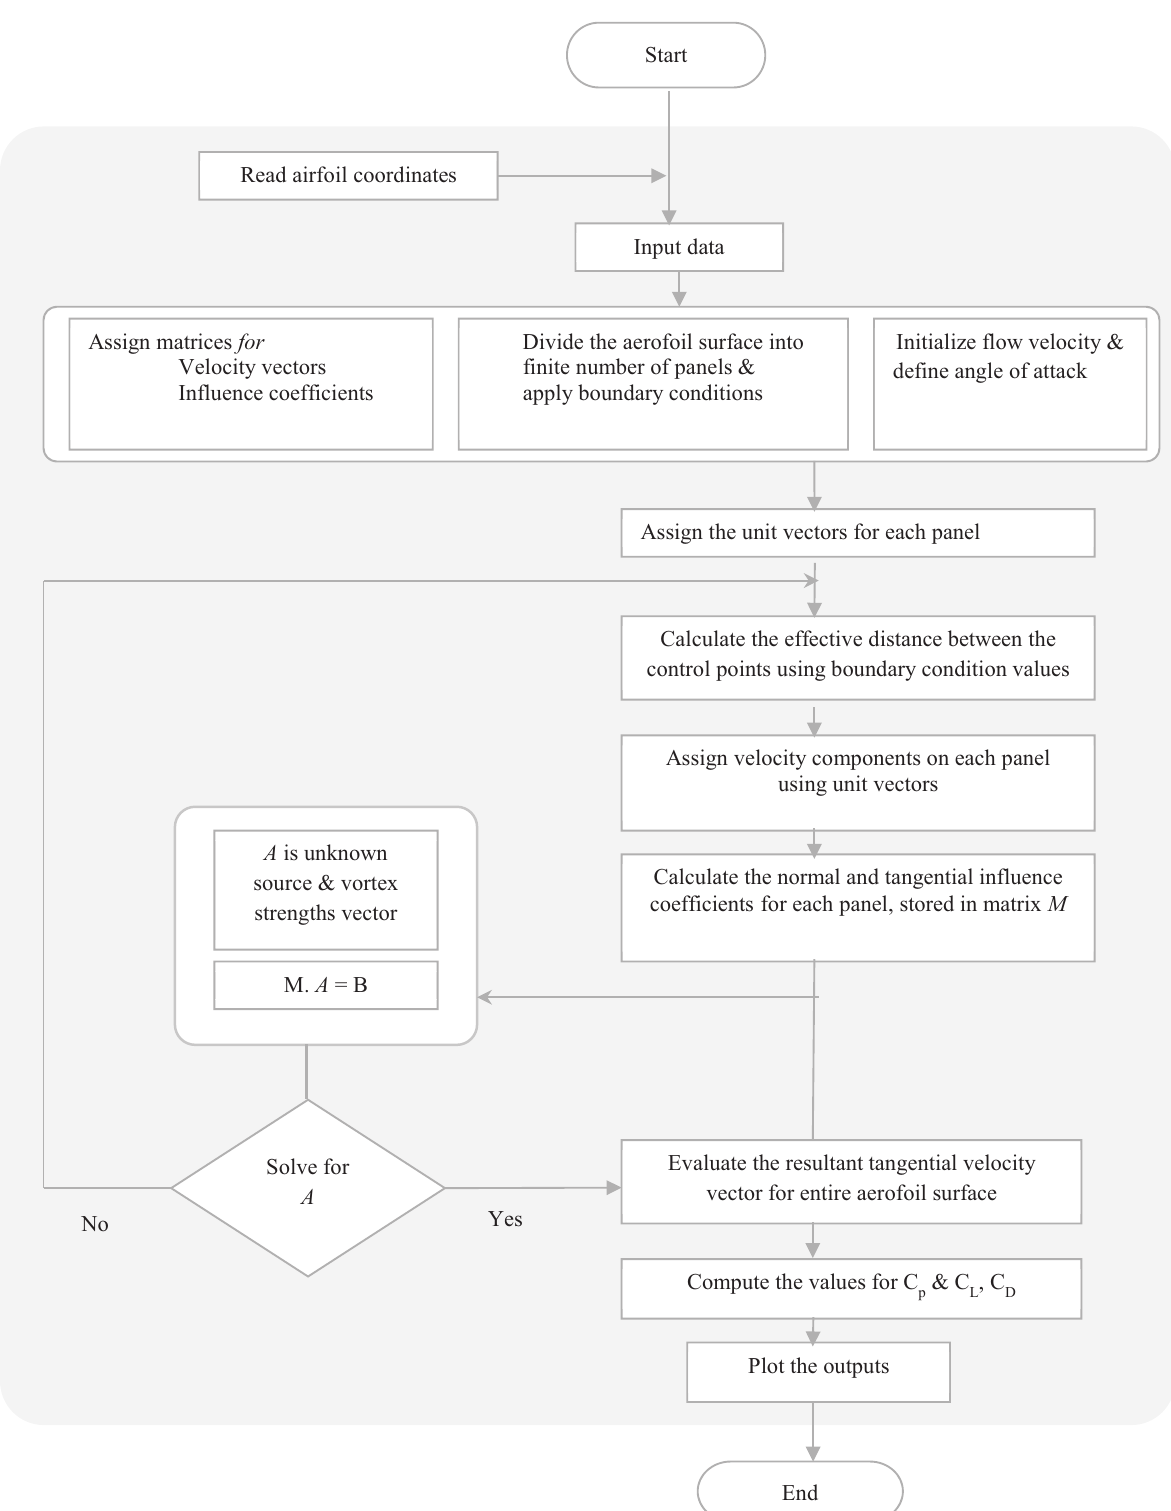
Figure 8. Computational routine of 2D panel method implemented in MATLAB (Dwivedi et al.,